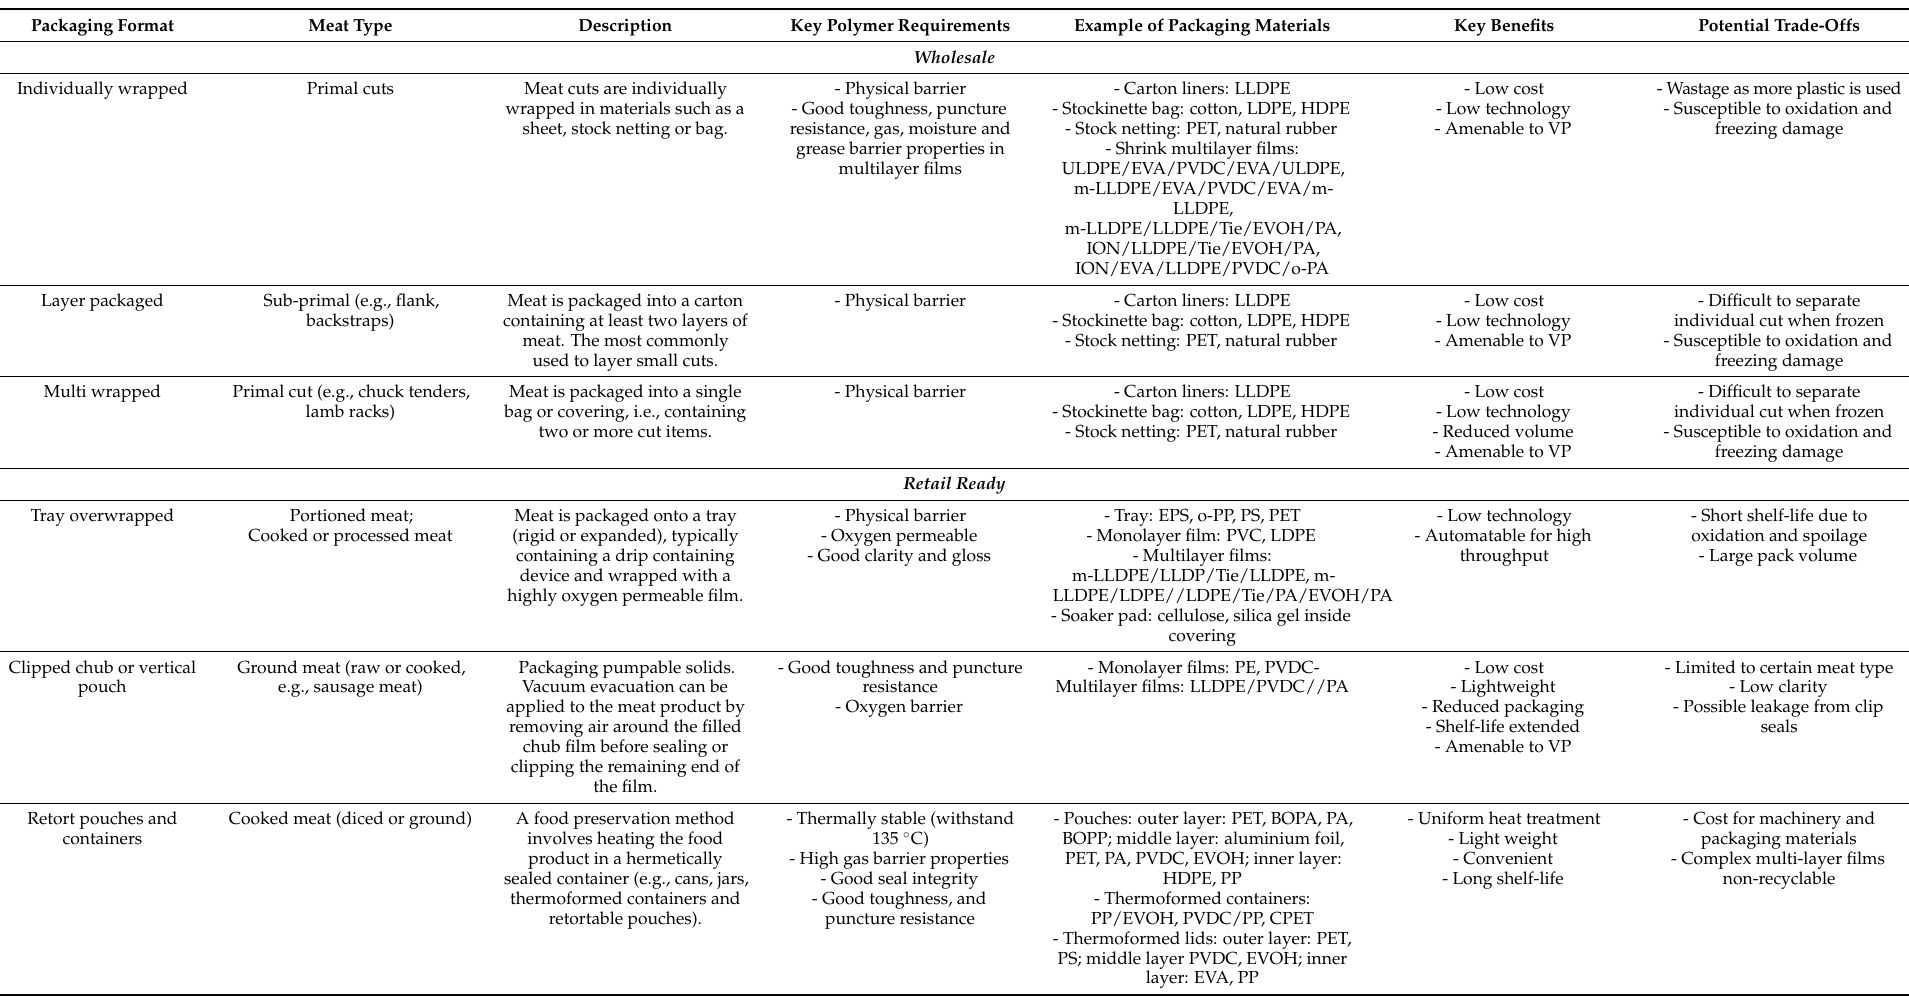
Table 1. Summary of packaging formats used for wholesale and retail meat